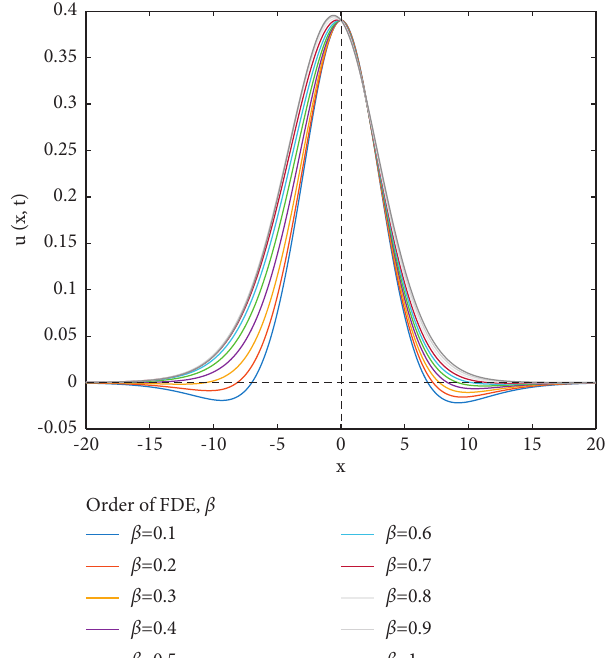
Figure 6: 2D fractional spatial numerical solution u ( x ) at orders α � 0 . 9 , β � 1 , κ � 3 , δ � 5, and time t � 0 .